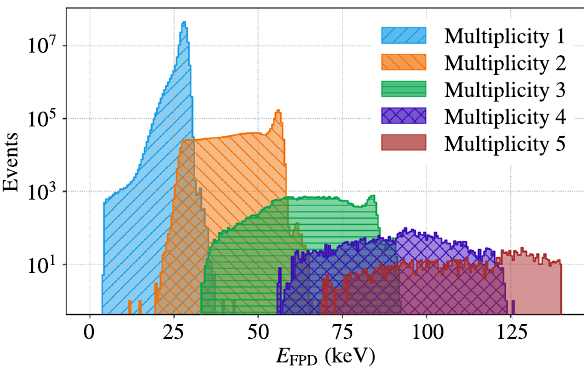
Fig. 5 Reconstructed event energy in the focal-plane Si-detector for all events accumulated during the integral response function measure- ments at 86% nominal column density ρ 0 d . The decomposition with the dedicated pile-up correction method shows that the different multi- plicity regions overlap. This effect does not allow for a simple pile-up correction based on event energy